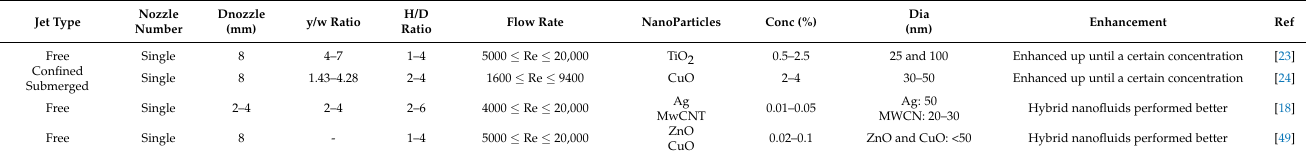
Table 6. Summary of past experimental studies on swirling impinging jets.